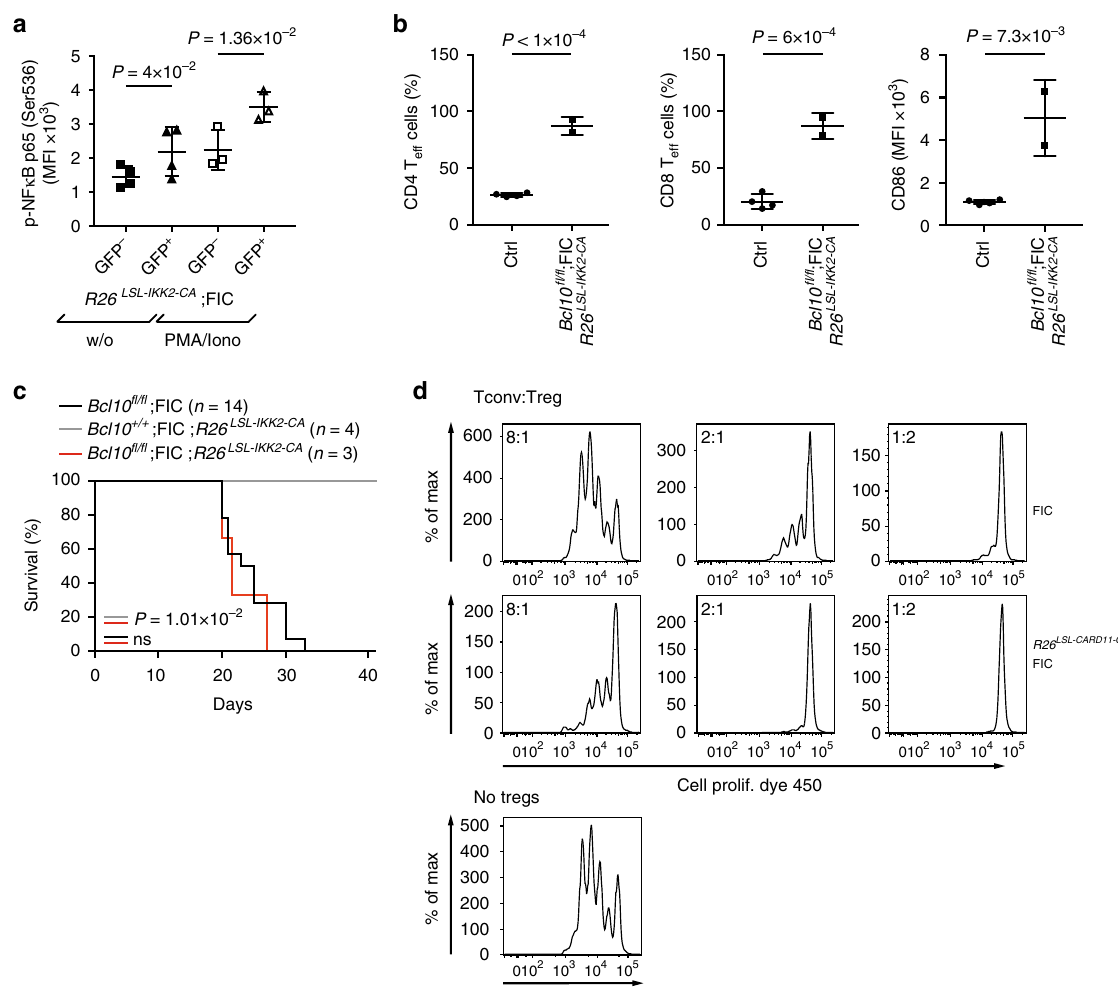
Fig. 4 Enforced I κ B kinase (IKK) activation cannot rescue the Bcl10 de fi ciency in regulatory T cells (Tregs). a PhosFlow experiment to detect the median fl uorescence intensity (MFI) of phospho-nuclear factor- κ B (p-NF- κ B) p65 at serine 536 in the viable CD4 + Foxp3 + Treg population in spleen samples of Rosa26 LSL-IKK2-CA ;FIC female mice with or without (w/o) PMA/ionomycin stimulation. Due to random X inactivation, female mice were mosaic with GFP + Tregs expressing the IKK2-CA variant and GFP – non-IKK2-CA-expressing Tregs. Statistical signi fi cances between the GFP – and GFP + populations were assessed by a two-tailed paired t test. b Quanti fi ed analysis of CD4 + Foxp3 – CD44 hi CD62L lo -gated splenic CD4 T effector (T eff ) cells (left graph), CD8 + CD44 hi CD62L lo -gated splenic CD8 T eff cells (middle graph), and the median fl uorescence intensity (MFI) of cell surface CD86 on CD19 + B220 + -gated splenic B cells (right graph) of either wild-type control (Ctrl) or diseased Bcl10 fl / fl Rosa26 LSL-IKK2-CA ;FIC male mice. A statistical signi fi cance between genotypes was assessed by a two-tailed unpaired Student ’ s t test. c Survival curves of Bcl10 + / + Rosa26 LSL-IKK2-CA ;FIC control (gray line, n = 4), Bcl10 fl / fl Rosa26 LSL-IKK2-CA ;FIC (red line, n = 3), and Bcl10 fl / fl ;FIC male mice (black line, n = 14). Survival equals the day the animal had to be sacri fi ced to avoid severe burden. Statistical signi fi cances between the survival curves were calculated by a log-rank (Mantel – Cox) test; (ns) not signi fi cant. d In vitro Treg- suppressor assay assessing the suppressor activity of Tregs of FIC and Rosa26 LSL-CARD11-CA ;FIC mice. Sorted splenic CD4 + CD25 – CD45RB hi naive conventional T cells of FIC mice were labeled with Cell Proliferation Dye eFluor 450 and cultivated for 3 days without any Tregs (lower panel), with sorted splenic CD4 + CD25 + CD45RB lo Tregs of FIC mice (upper panel) or with sorted splenic CD4 + CD25 + CD45RB lo GFP + Tregs of Rosa26 LSL-CARD11-CA ;FIC mice (middle panel) in the presence of irradiated splenocytes and soluble anti-CD3. FACS plots show the proliferation pro fi les of Cell Prolif Dye 450 + -gated cells cultivated with different ratios of Tregs. Bars in a , b represent the mean ± D. Data in a , b are cumulative from two independent experiments and data in d are representative of three independent experiments. Source data are provided as a Source Data